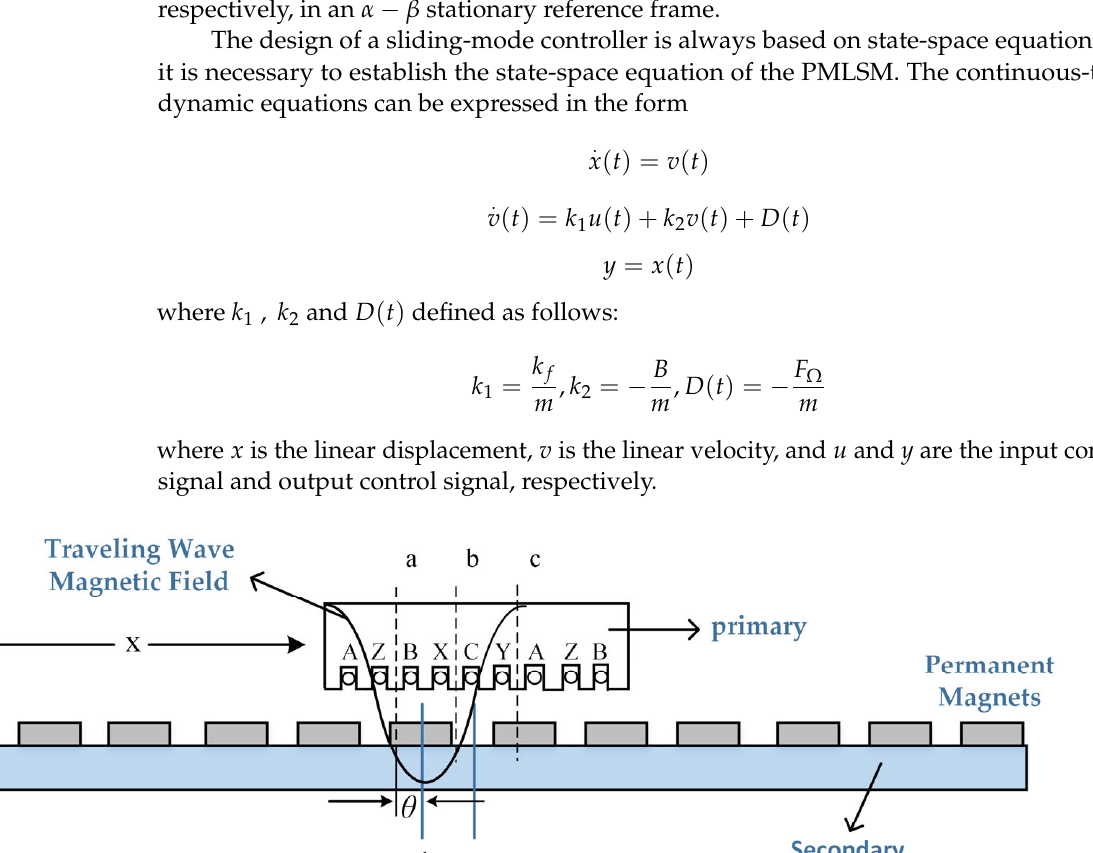
Figure 2. Coordinate system of the PMLSM model: 𝜃 is the angle between the A-phase winding axis and the permanent magnet axis, 𝜓 (cid:3033) is the permanent magnet flux linkage. 3. SMC Theory 3.1. Fundamental Theroy of SMC Sliding-mode control (SMC) is a robust and effective control method for nonlinear systems suffering from parametric uncertainties and external unknown disturbances [13] [21–23]. SMC essentially utilizes the discontinuous control signal to force the system states to operate on a predesigned surface, i.e., the occurrence of the so-called sliding mode dy- namic or sliding motion is enforced. Due to the fact that sliding motion can be designed, it is insensitive to matched disturbances and uncertainties. The general structure of SMC is described below. Assuming that the nonlinear system is of the form 𝑥(cid:4662) ( 𝑡 ) = 𝑓 ( 𝑥 , 𝑡 ) + 𝐵 ( 𝑥 , 𝑡 ) 𝑢 ( 𝑡 ) + 𝑑 ( 𝑥 , 𝑡 ) (12) where 𝑥 ∈ 𝑅 (cid:3041) is the system state vector, 𝑢 ( 𝑡 ) ∈ 𝑅 (cid:3040) is the control input variable, and 𝑑 ( 𝑥 , 𝑡 ) ∈ 𝑅 (cid:3041) denotes the disturbances and uncertainties, | 𝑑 ( 𝑥 , 𝑡 )| ≤ 𝐷 . First, the switching function 𝑠 ( 𝑥 ) ∈ 𝑅 (cid:3040) is defined as 𝑠 ( 𝑥 ) = [ 𝑠 (cid:2869) ( 𝑥 ) 𝑠 (cid:2870) ( 𝑥 ) ∙∙∙ 𝑠 (cid:3040) ( 𝑥 )] (cid:3021) (13) and 𝑠 ( 𝑥 ) = 0 denotes the switching surface, also known as sliding-mode surface. Then, the structure of sliding-mode control law is always 𝑢 (cid:3036) ( 𝑡 ) = (cid:3420)𝑢 (cid:3036)(cid:2878) ( 𝑡 ) 𝑠 (cid:3036) ( 𝑥 ) > 0 𝑢 (cid:3036)(cid:2879) ( 𝑡 ) 𝑠 (cid:3036) ( 𝑥 ) < 0 𝑖 = 1,2, … , 𝑚 , (14) where 𝑢 (cid:3036)(cid:2878) ( 𝑡 ) ≠ 𝑢 (cid:3036)(cid:2879) ( 𝑡 ) , and is discontinuous around the sliding-mode surface. With respect to system motion, a system controlled by SMC consists of two motion phases: (1) the reaching phase, in which the system states are driven to the sliding-mode surface from their initial states in a finite time; and (2) the sliding mode phase, in which